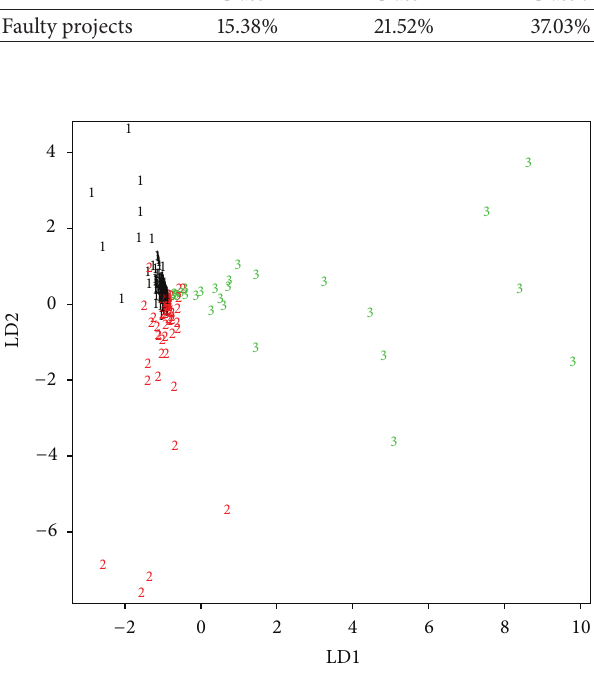
Figure 3: Linear discriminant analysis projection on the first (LD1) and second (LD2) discriminant